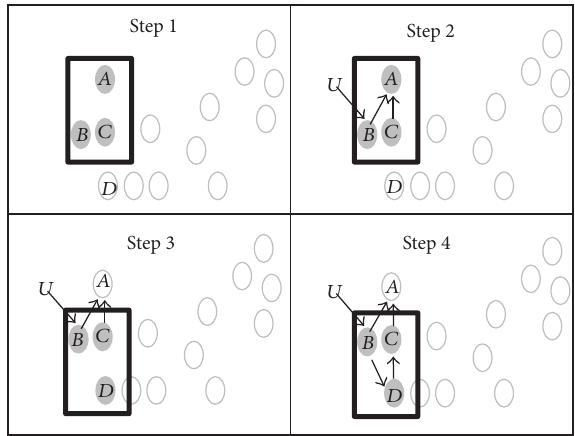
Figure 1: Schematic of MANI steps. Step 1: selection of three genes, 𝐴 , 𝐵 , and 𝐶 , for the initial window. Step 2: inferring regulatory relationship among genes within the window as indicated by arrows. External input is shown by 𝑈 . Step 3: migrating window to accommodateanewgene( 𝐷 )withtheclosestexpressionassociation with two genes (genes 𝐵 and 𝐶 ) and their associated regulatory relationships from the previous window. Step 4: inferring regulatory relationships between thegenes in thenewwindow. Steps 3 and 4 are repeated until all the genes in the network are included in a window at least once.